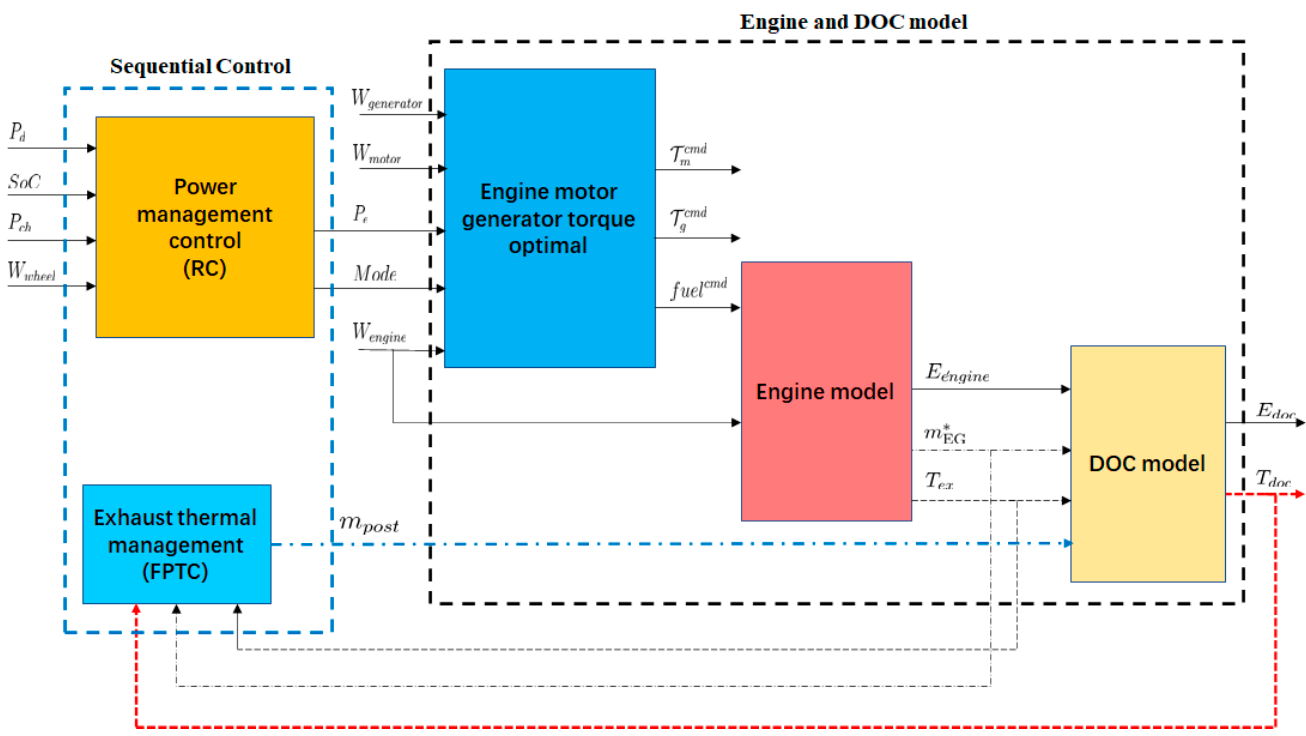
Figure 12. Schematic of sequential control for power split and exhaust thermal management (RC + FPTC).